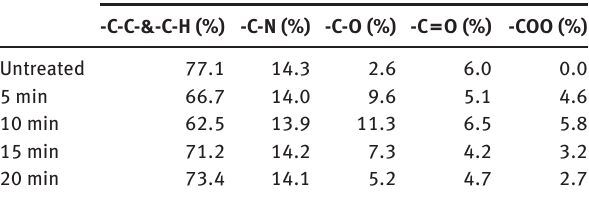
Table 2: The concentration of the different carbon groups on the polyimide surface.